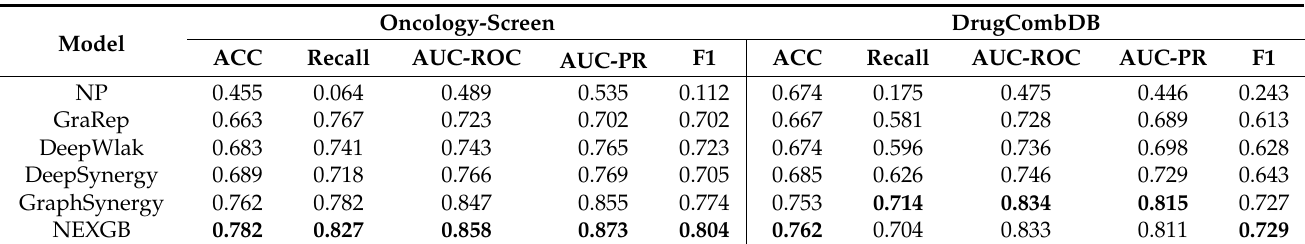
Table 3. The performance of NEXGB compared with baselines.